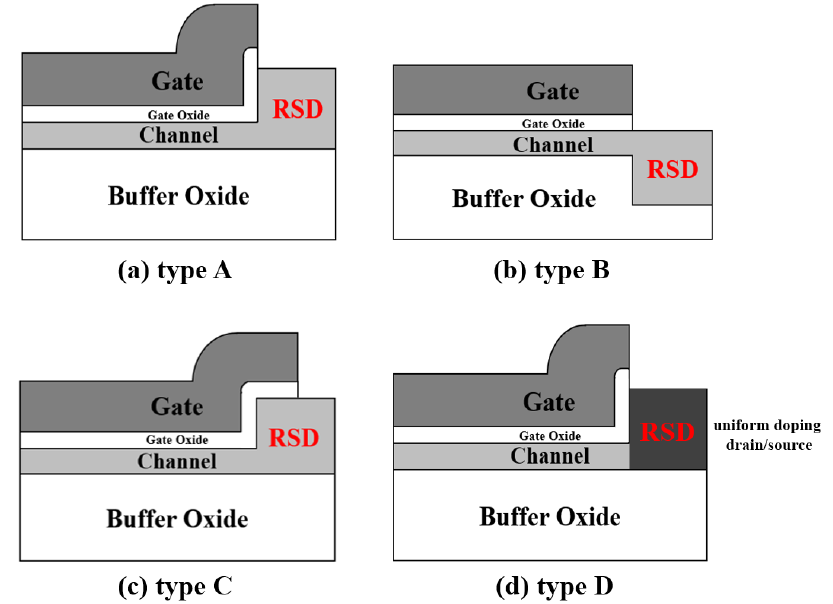
Figure 1. The cross section for various types of raised source/drain (RSD)